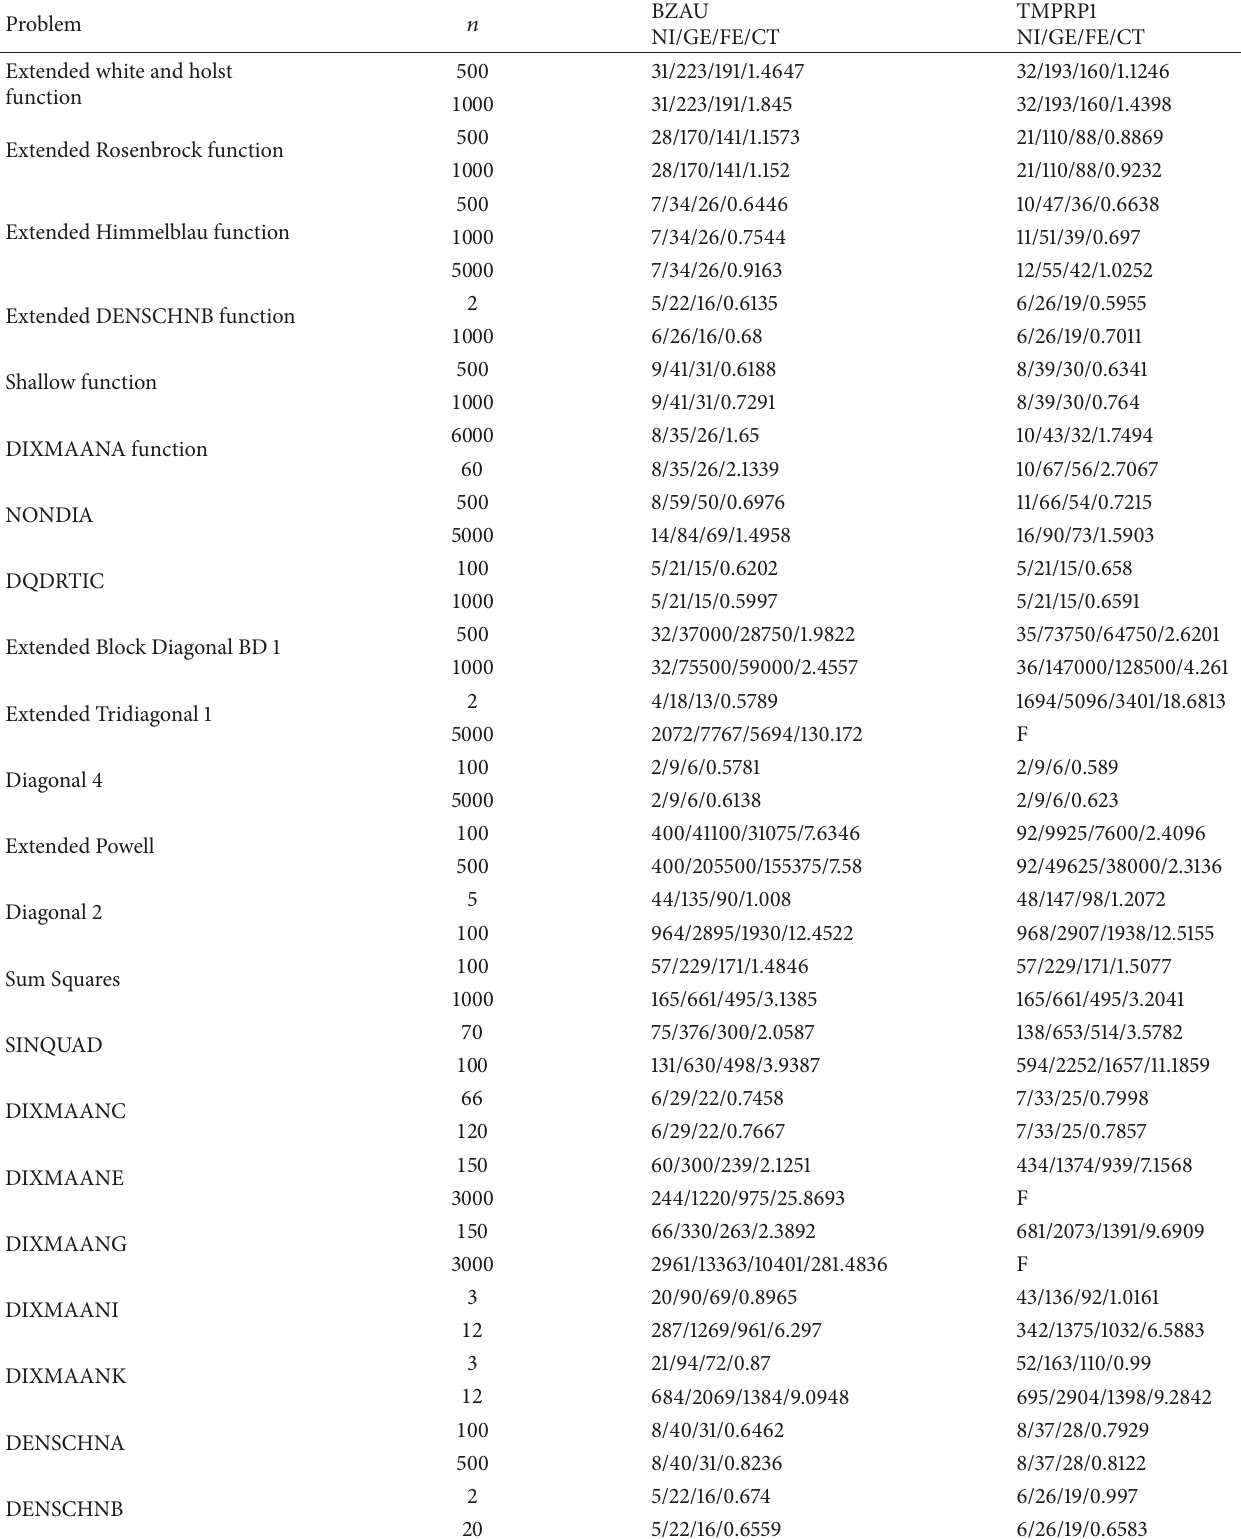
Table 1: A list of test problem